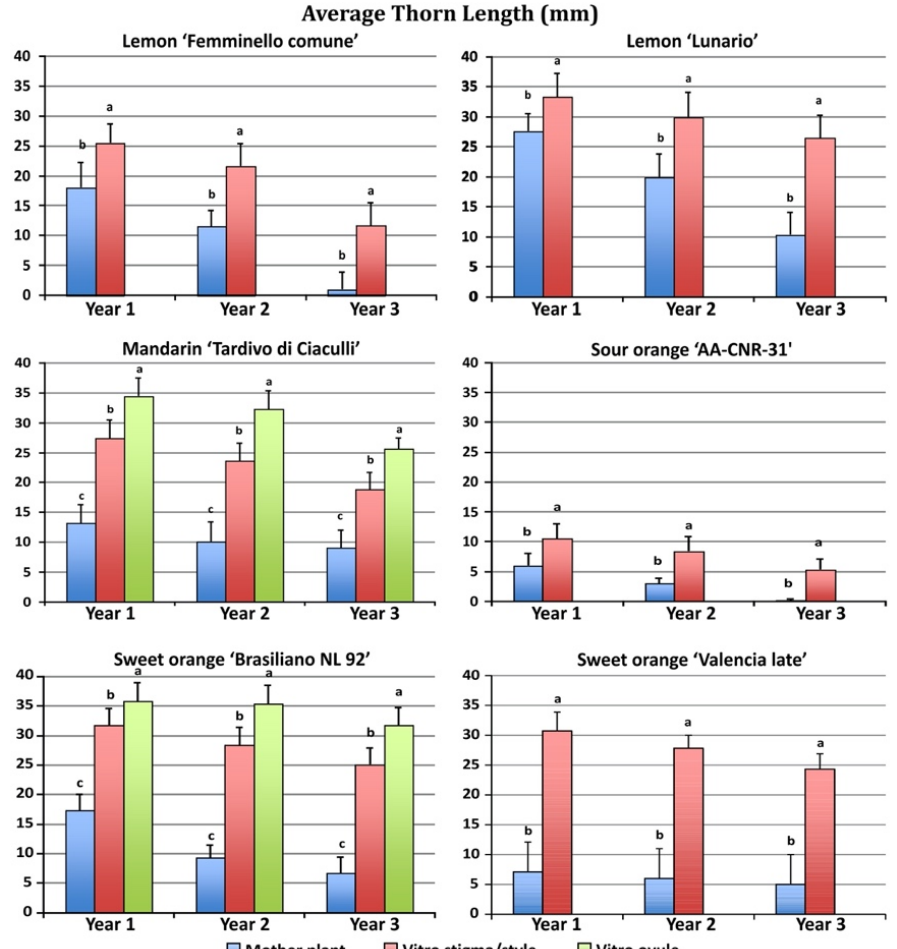
Figure 3. Average thorn length in plants regenerated from different explants growing in the field during the first three years after grafting. Different letters on bars indicate significantly different values at a particular genotype according to the t -test for ‘Femminello comune’, ‘Lunario’ lemon, ‘AA CNR 31’ sour orange and ‘Valencia late’ sweet orange and according to Tukey’s multiple comparison test for ‘Tardivo di Ciaculli’ mandarin and ‘Brasilian NL92’ sweet orange. Tests were performed at p < 0.05 significance level within each year. Bars indicate standard error. Regenerated plants after one year of growth in the field showed much longer thorns than mother plants. Moreover, the undeveloped ovule regenerants showed a longer thorn length when compared to the stigma/style regenerants. ‘Brasiliano NL 92’ sweet orange stigma/style and undeveloped ovule regenerants showed the highest thorn length (31.7 and 35.8 mm, respectively) in the first year, yet also the mother plants showed long thorns (17.3